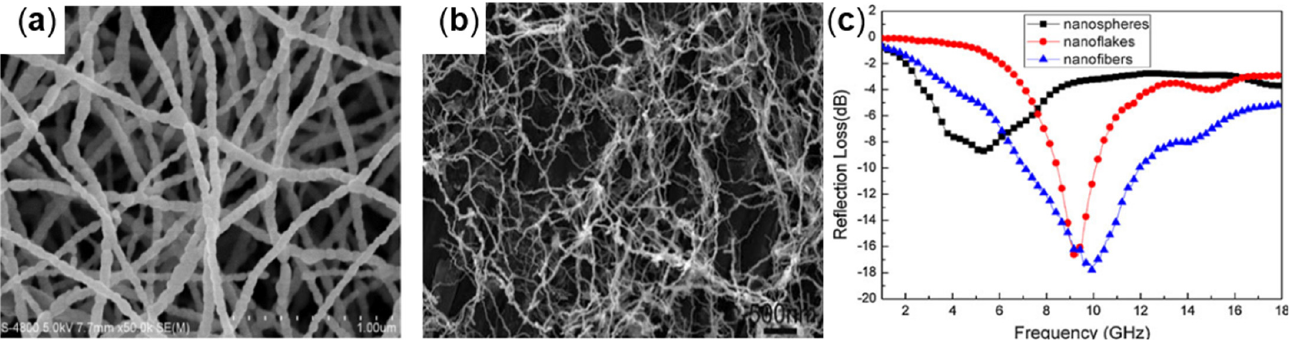
Figure 5. ( a ) SEM of Fe 3 O 4 nanofibers, reproduced with permission from Ref. [53], Copyright 2015, Springer Nature. ( b ) SEM and ( c ) RL plot of Fe nanofibers, reproduced with permission from Ref. [54], Copyright 2011, Springer Nature. Table 3. The electromagnetic absorption performance of wire-like Fe, dendrite-like Fe, and cube shape-like